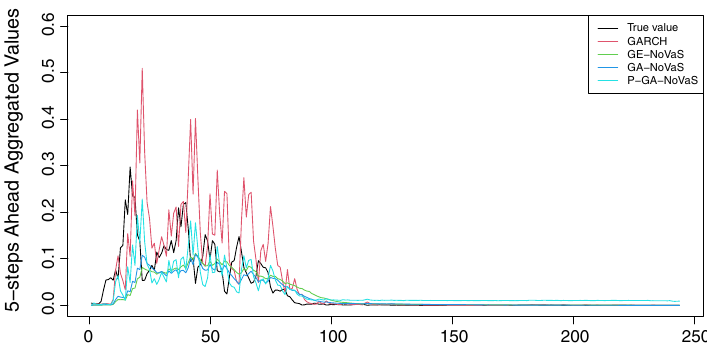
Fig. 3 The curves of different methods’ 5-steps ahead aggregated predictions on 500 simulated Model 8 data and actual values